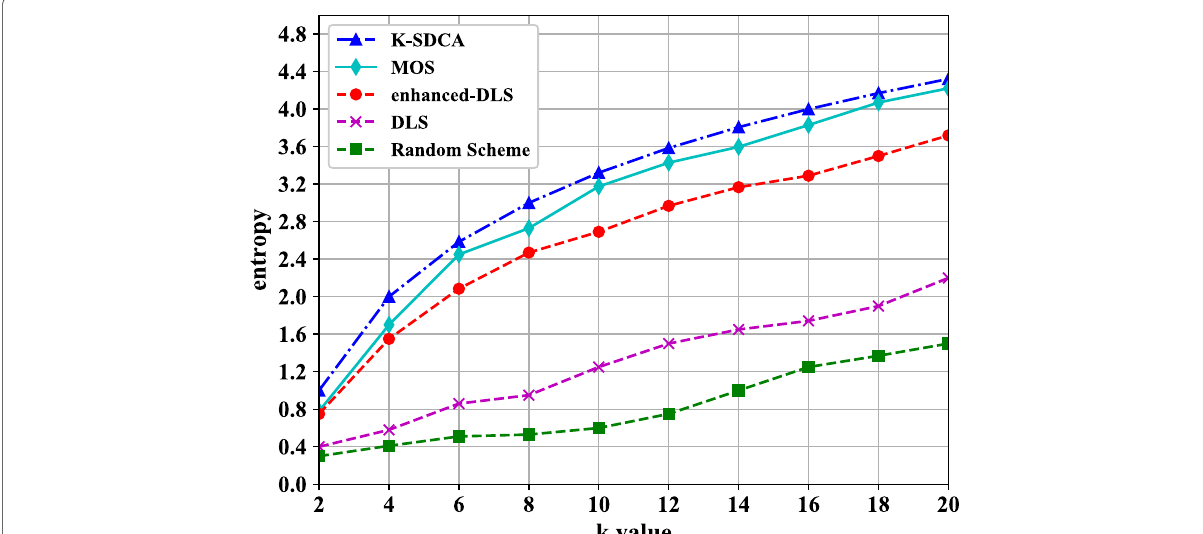
Fig. 10 Comparison of anonymity among different algorithms under different k values. It shows that the degree of anonymity gradually increases with the raise of k . Compared to other four algorithms, the dummy locations generated by K-SDCA has a better